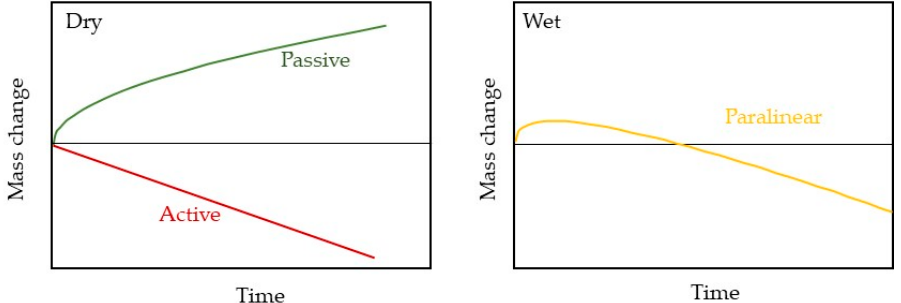
Figure 4. Schematic image on oxidation kinetics of SiC at high temperatures in dry and wet atmos- pheres.